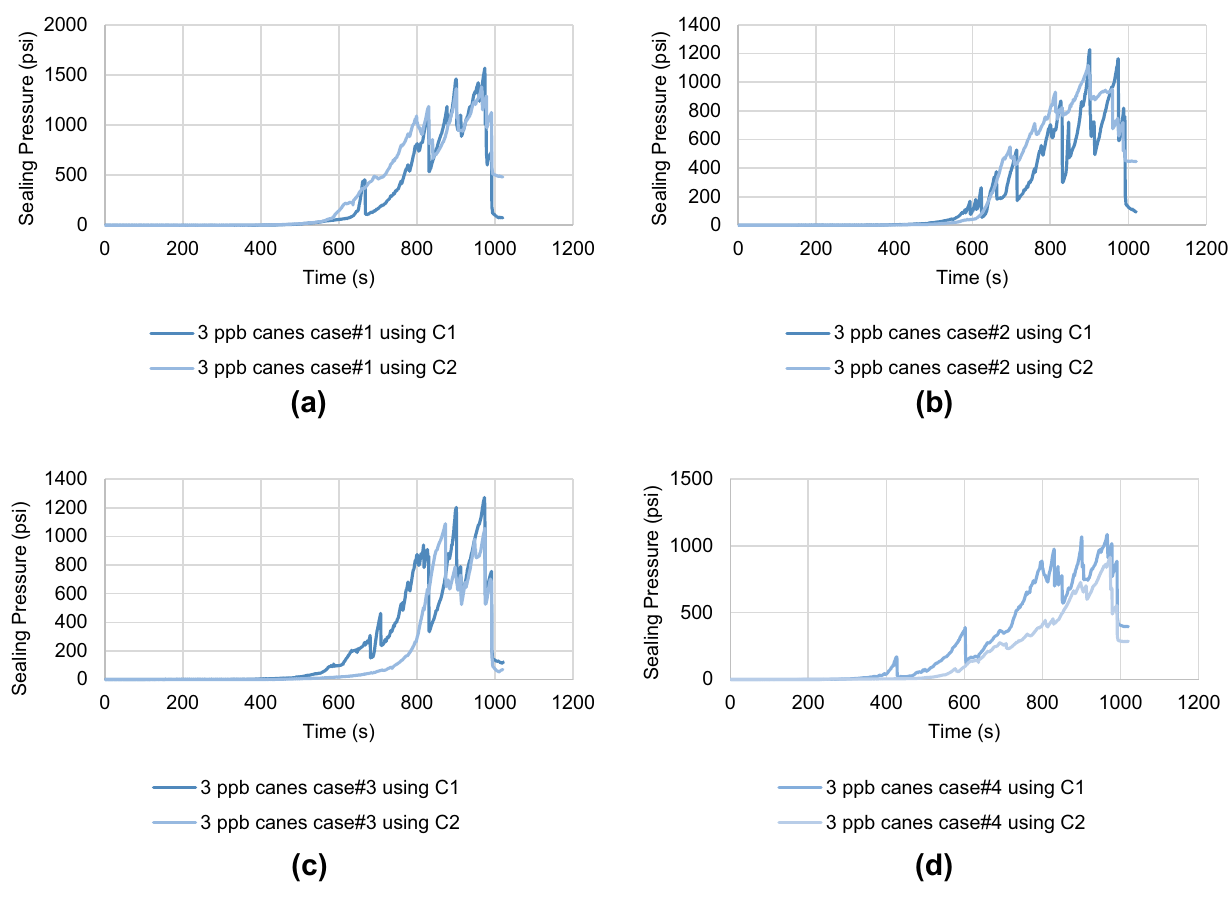
Fig. 15 HPA Pressure versus Time plot for 3 ppb Canes showing maximum sealing pressure at different fracture widths, a case#1, b case#2, c case#3, d